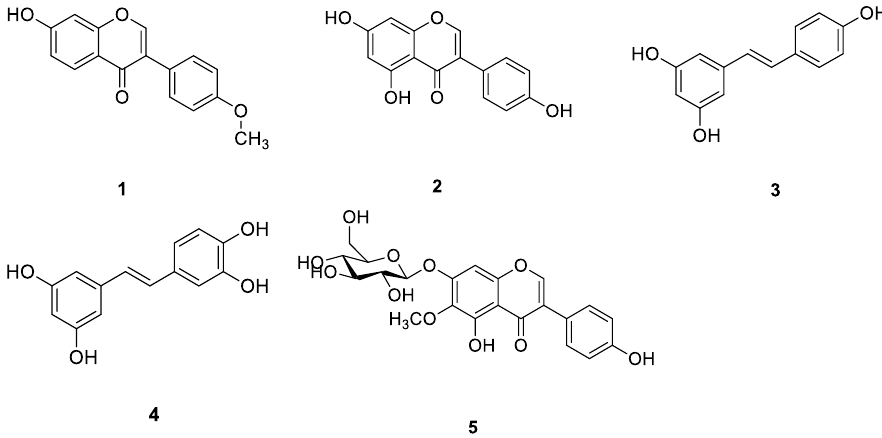
Figure 7. Chemical structures of Compounds 1 – 5.